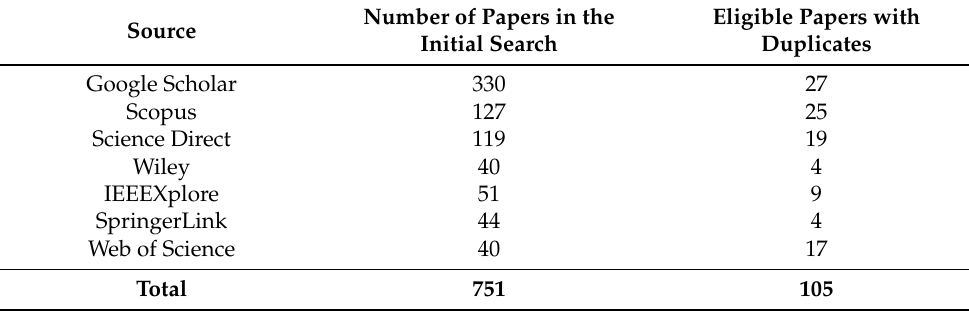
Number of Papers in the Initial Search